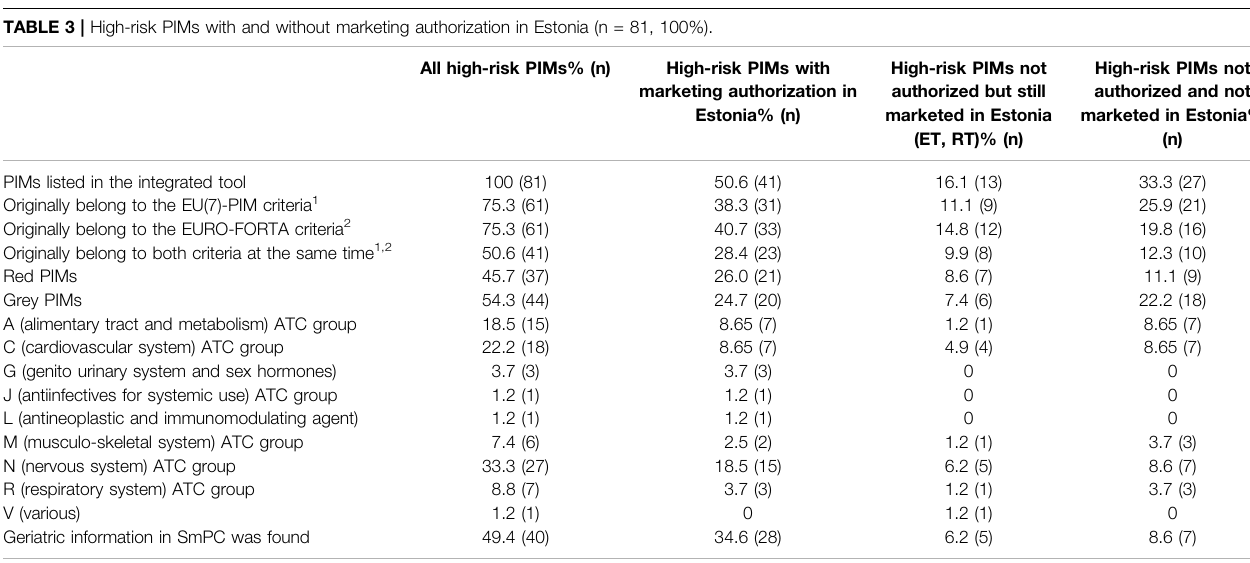
All high-risk PIMs% (n) High-risk PIMs with